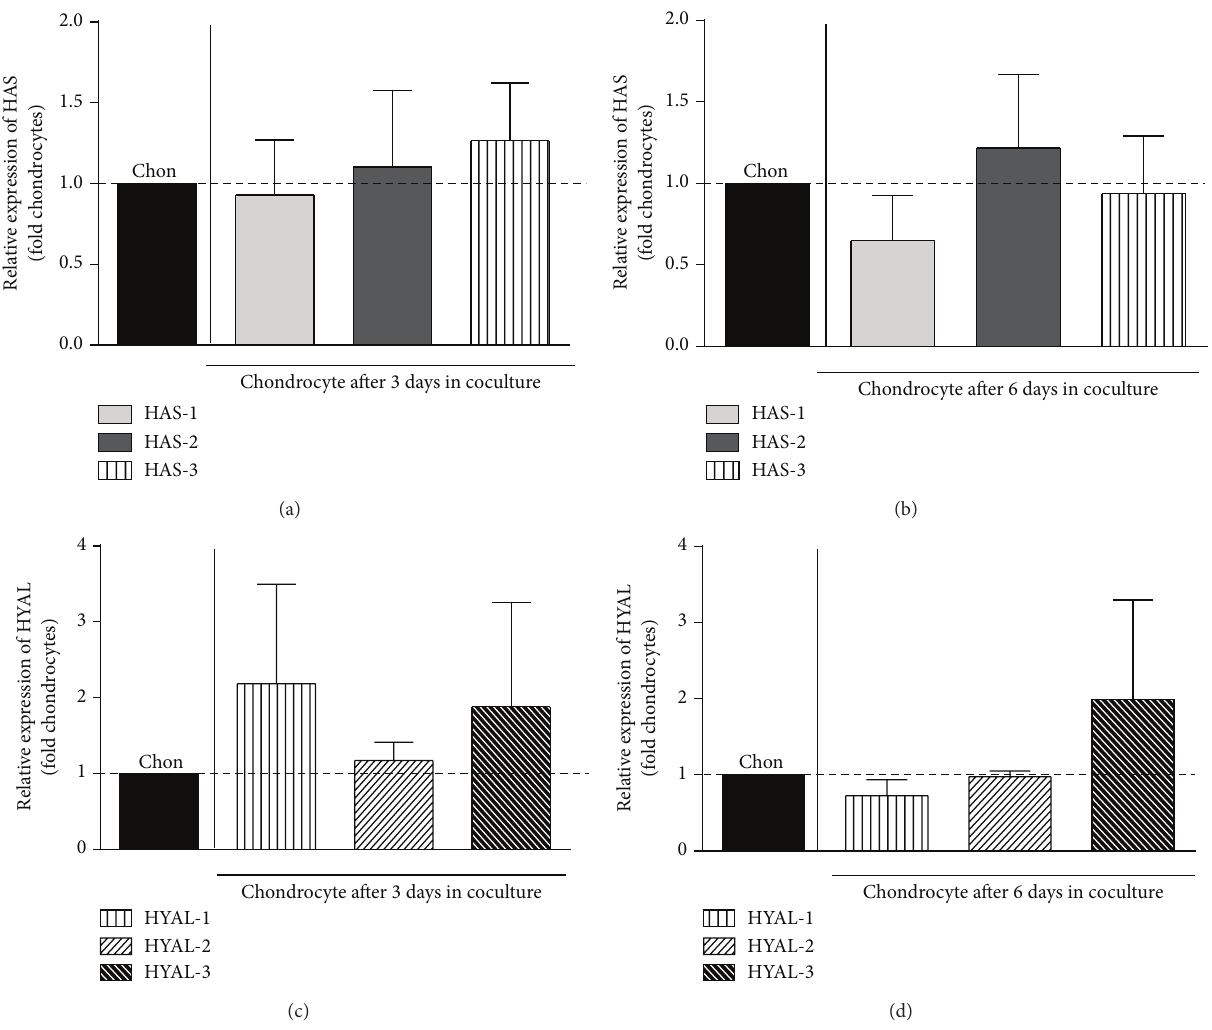
Figure 5: Hyaluronan enzyme mRNA expression in OA-chondrocytes after coculture. mRNA expression of hyaluronan synthase- (HAS-) 1, HAS-2, and HAS-3 (a-b) and hyaluronidase- (HYAL-) 1, HYAL-2, and HYAL-3 (c-d) after coculture relative to time-matched and cell- matched controls. Expression of HAS in cocultivated chondrocytes (Chon) relative to Chon monoculture after 3 days (a) and 6 days (b) ( 𝑛 = 5 ); expression of hyaluronidases in cocultivated chondrocyte relative to Chon monoculture after 3 days (c) and 6 days (d) ( 𝑛 = 5 ). Bars represent the mean fold change value ± SEM relative to chondrocyte in monoculture of hyaluronan enzymes. Statistical significance based on unpaired t -test was set according to the number of asterisks, as follows: ∗ 𝑃 ≤ 0.05 , ∗∗ 𝑃 ≤ 0.001